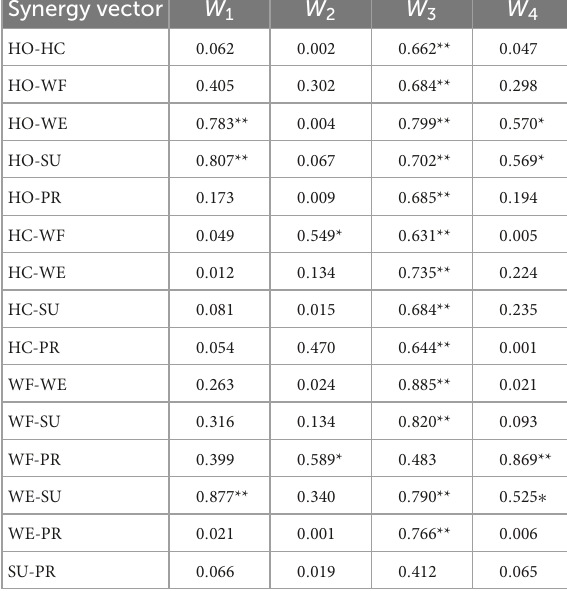
TABLE 4 Spearman’s correlation coefficients among muscle synergetic modules from different movements.